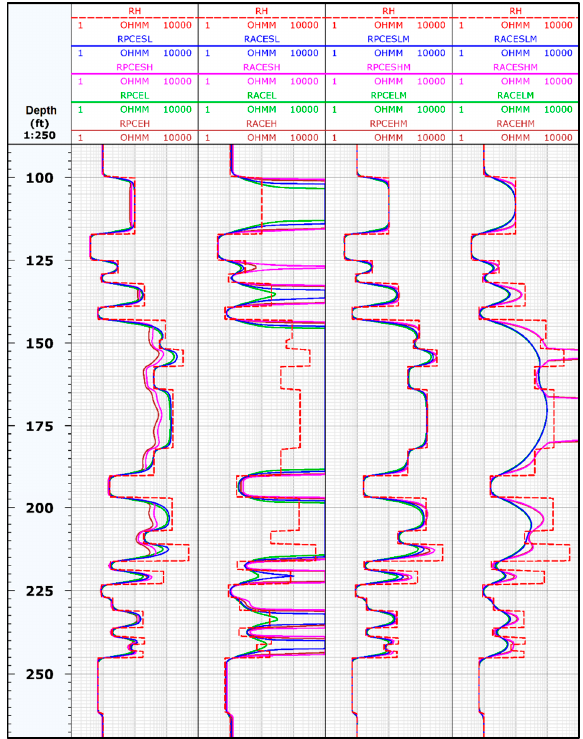
Figure 8. Comparison of dielectric constant offset before and after correction. The first track is the depth track. The second track is the phase shift resistivity track, where the measured signal is not o ff set-corrected. The third track is that amplitude a tt enuation resistivity track, where the measured signal is not o ff setcorrected; the fourth track is a phase shift resistivity track after o ff set correction of that measured signal.